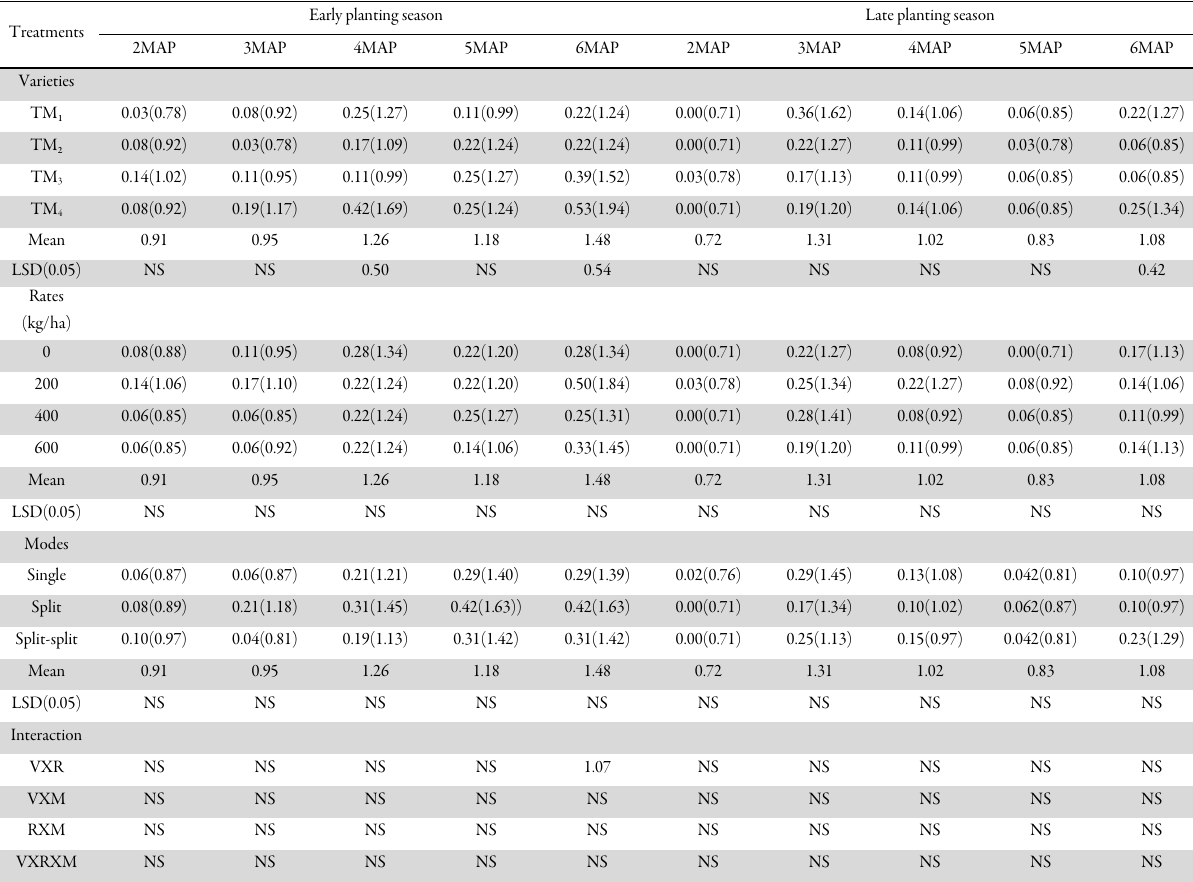
Table 2. Effect of varieties, rate, mode of NPK fertilizer and their interactions on the incidence of Z. variegatus on the field Treatments